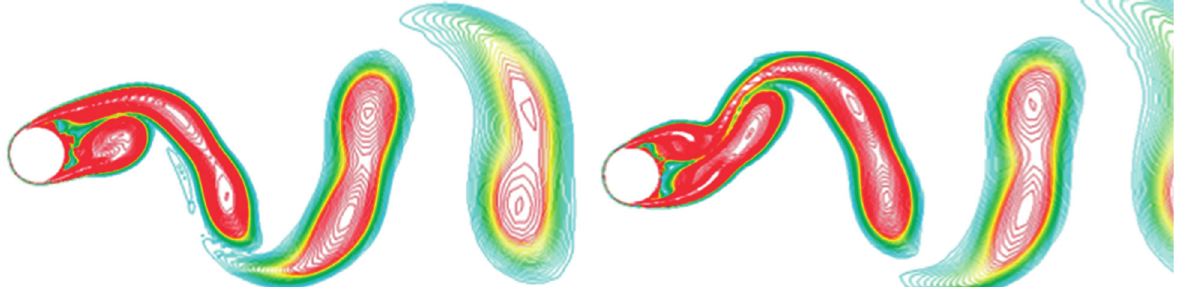
Figure 5: Vorticity contours of 2 P mode in one vibration period at A ∗ � 0 . 4, λ ∗ � 6 .